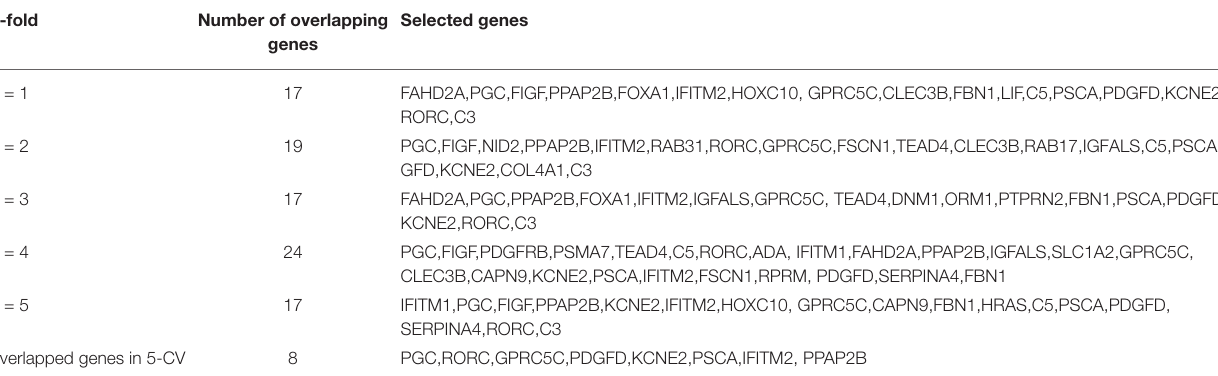
TABLE 5 | Selected genes from integrating gene expression and DNA methylation dataset. K-fold Number of overlapping Selected genes